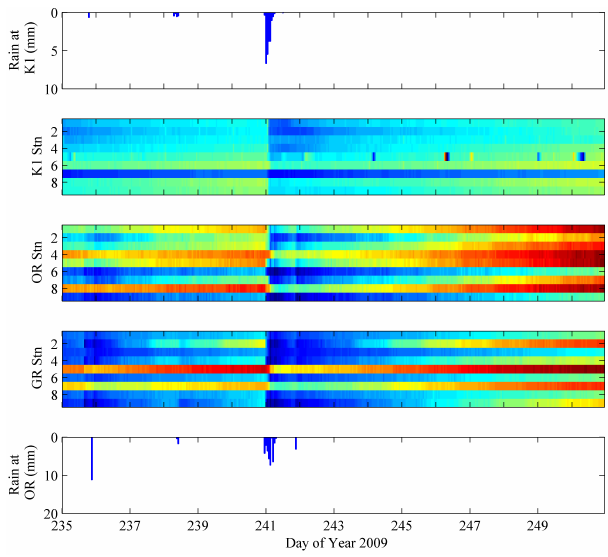
Fig. 11. Analysis of the mean relative difference before and after rain event 2 at a depth of 10cm at K1, OR and GR. The colour scale changes from red (dry) to blue (wet) where mean soil moisture values ( δ jk = 0) are cyan. For visual interpretation the colour map is stretched for each image and colour values are